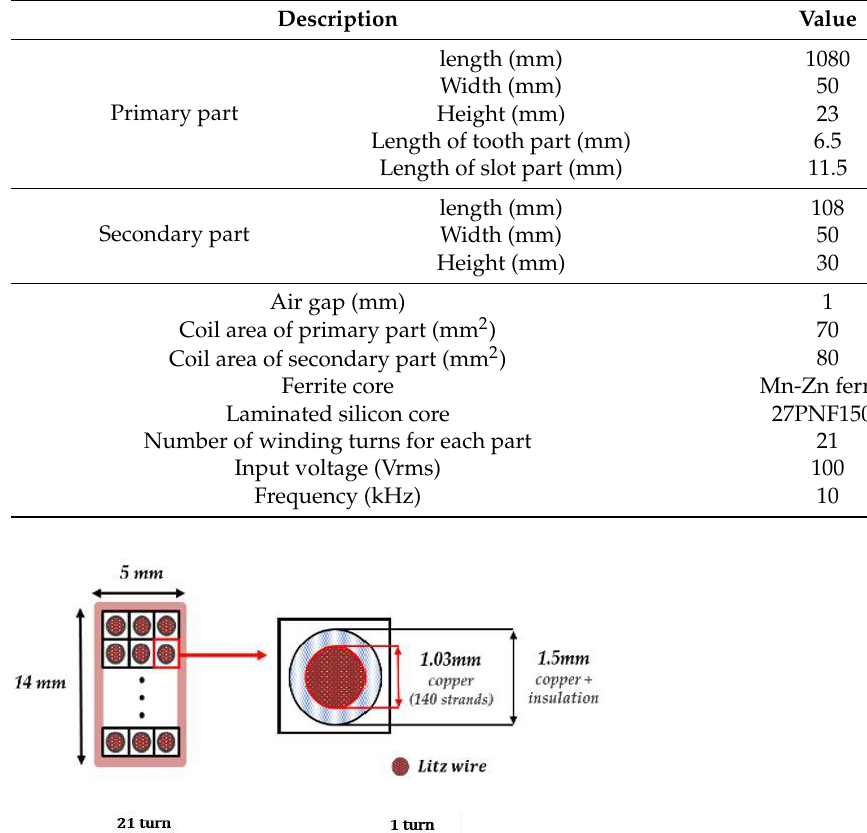
Figure 7. Configuration of the coil and coil area.